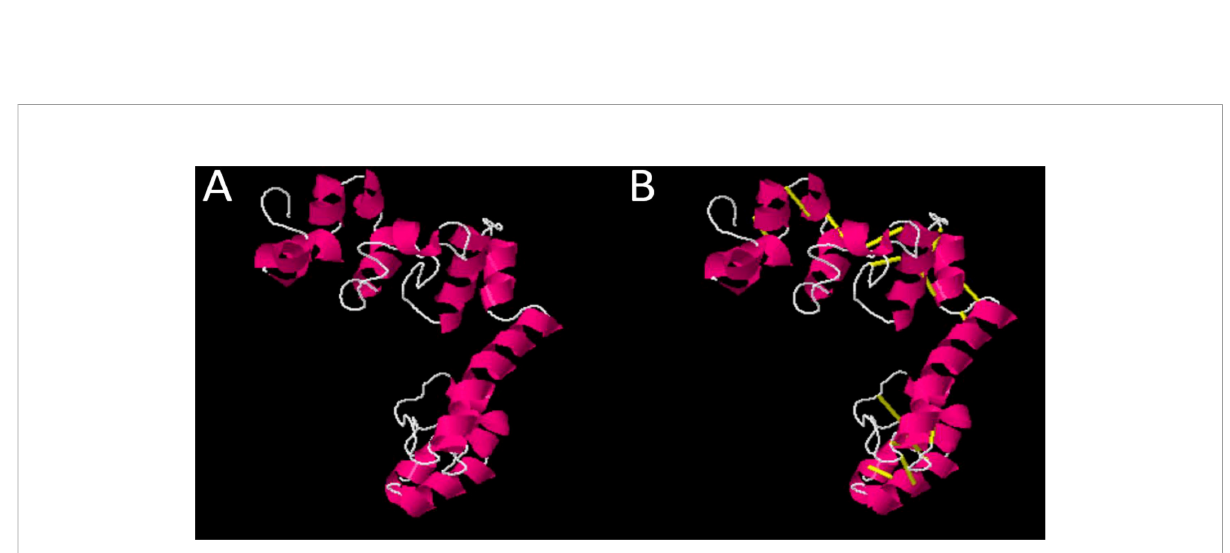
FIGURE 4 (A) Original vaccine structure (B) Mutated vaccine structure; in the mutated structure, yellow lines represent mutated residues.